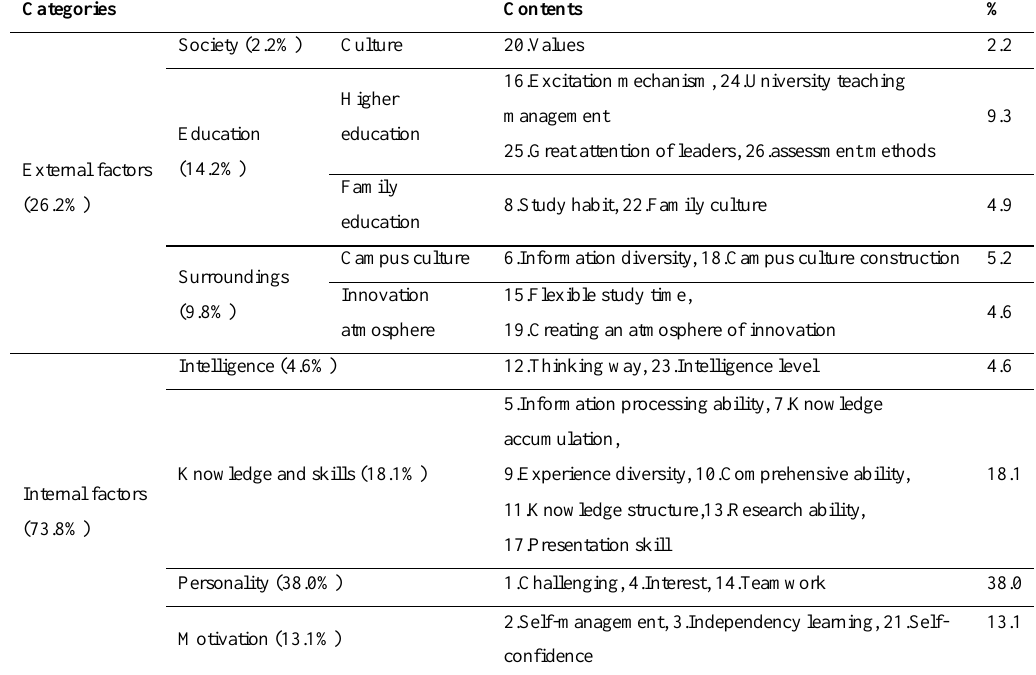
Table 3 Key factors influencing creativity development in applied